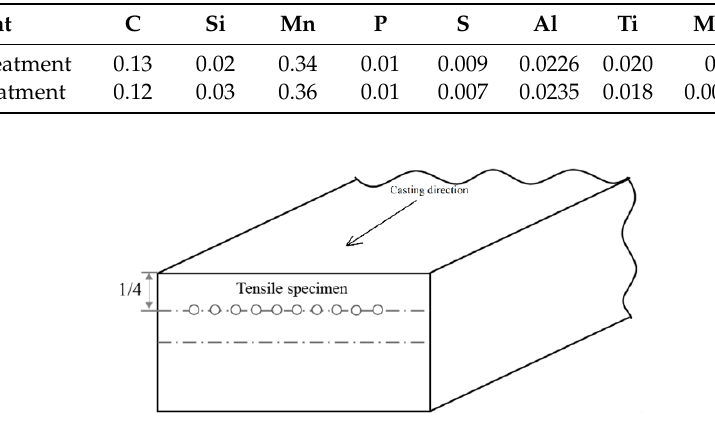
Figure 3. Sampling position for high-temperature tensile test.